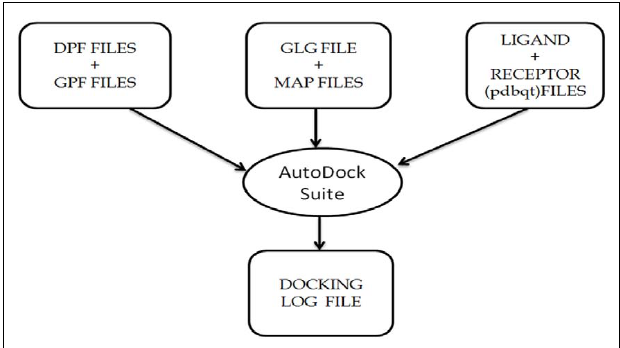
FIGUREA2 | Description of the usage ofAutoDock Suite in the AutoDock4 software package, that generates the final docking log file containing information about the final docked